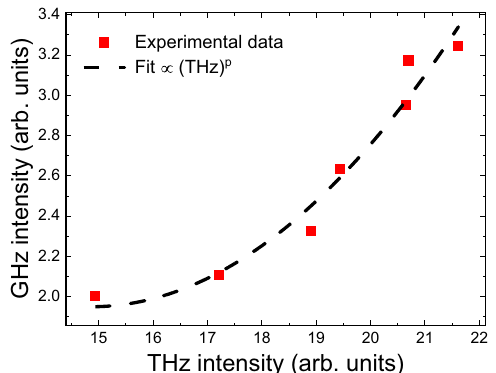
Fig. 3 Observation of second-order nonlinearity. mmWave intensity as a function of THz intensity (red squares) illustrating a nonlinear behaviour with an exponent of P = 2.1 ( fi t, black dashed line) corresponding to a second-order susceptibility. The measured intensities correspond to the integrated emission in each